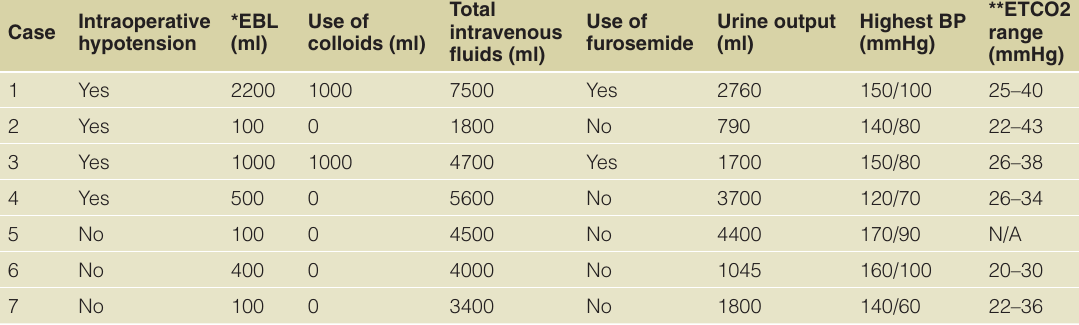
Table 3. Intraoperative management for brain tumour resection at the Cleveland Clinic, Ohio (2003–2008). Intraoperative Case